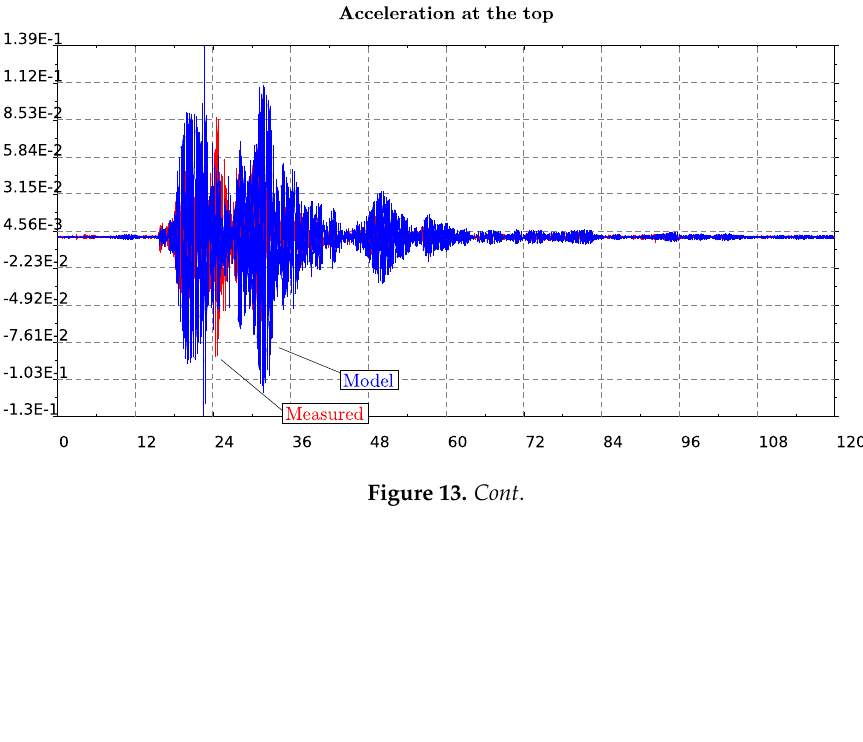
Figure 12. From top to bottom, recorded acceleration integrated in time to give velocities and displacements. On the left column East–West while on the right North–South components are plotted.